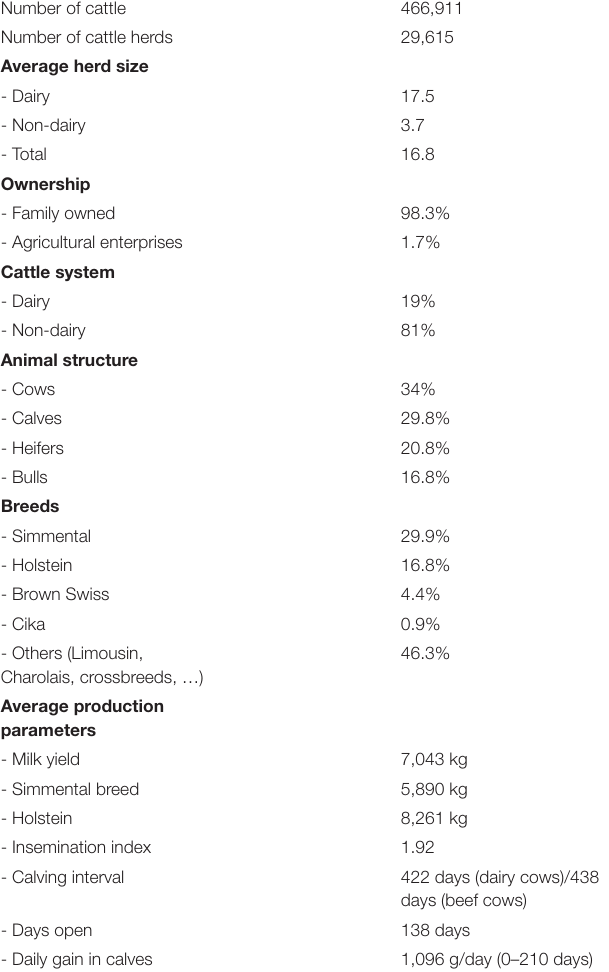
TABLE 1 | The structure and characteristics of the Slovenian cattle population in